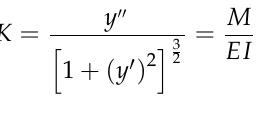
Figure 15. Tip deflection map in different combinations of base and fan frequencies.